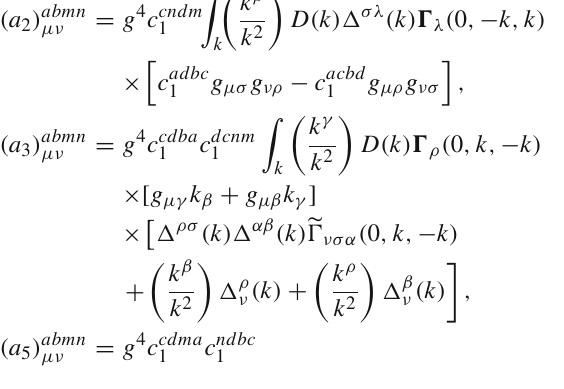
, denoted by T bcem and G bcem , 4 νρ 4 νρ 4 νρ